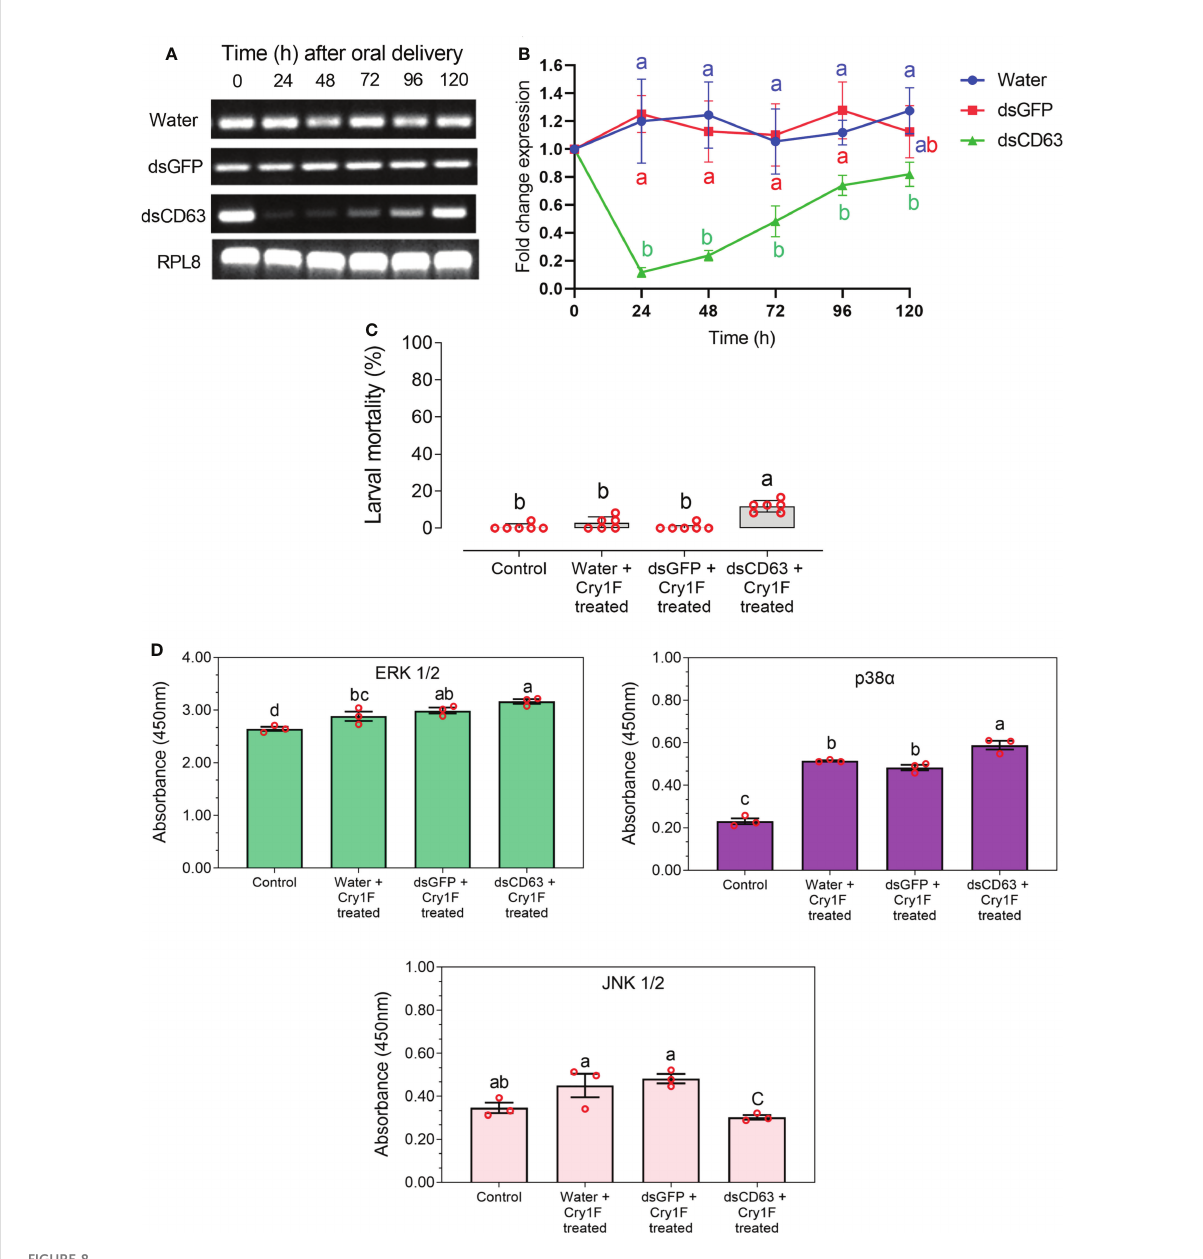
FIGURE 8 Functional testing of CD63 tetraspanin as putative Cry1F toxin receptor in ACB-FR using silencing by RNAi. (A) Ampli fi ed PCR product of CD63 gene after RNAi at different time points and compared with internal controls. (B) Relative mean fold CD63 expression ( ± SE) from three biological replicates detected using qRT-PCR. Different letters represent signi fi cantly different transcript levels (Tukey test, P < 0.05). (C) Mean percentage mortality after 48 h in ACB-FR larvae exposed to control or diet with Cry1F alone or in the presence of dsRNA targeting GFP or CD63. Shown are means and corresponding SE estimated from six independent bioassays represented by red circles. Different letters represent signi fi cant differences (Tukey test, P < 0.05). (D) MAPK activity in hemocyte lysates after CD63 gene knockdown and treatment with Cry1F (LC 50 dose) for 48 h in the ABC-FR strain, compared with control group. Blank values were subtracted from the respective experiments. Vertical bars under different letters were statistically signi fi cant and same letters were not signi fi cant (One Way ANOVA and post hoc LSD Tukey test, P